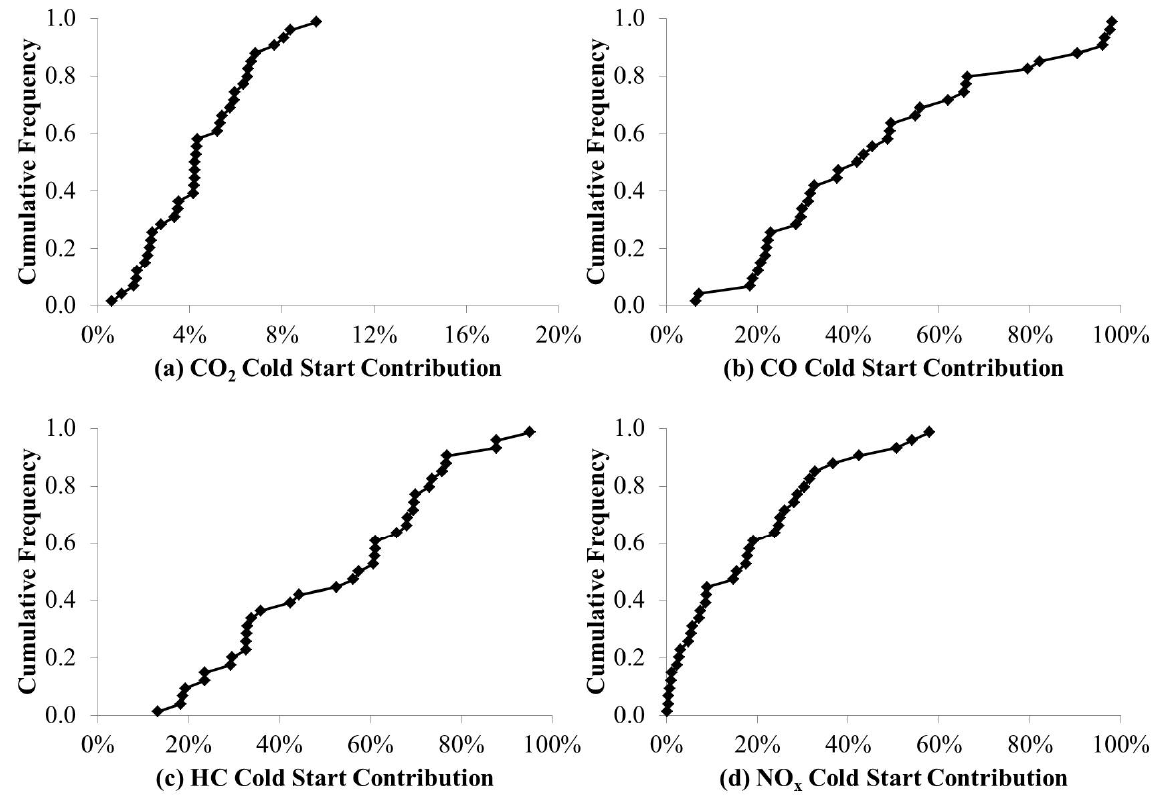
Figure 7. Cumulative frequency of idle cold start contributions of carbon dioxide, carbon monoxide, hydrocarbons, and nitrogen oxides based on measured data. Each panel includes 37 points. Each point represents one measured vehicle, with average idle cold start contribution over 8 one-way trips.